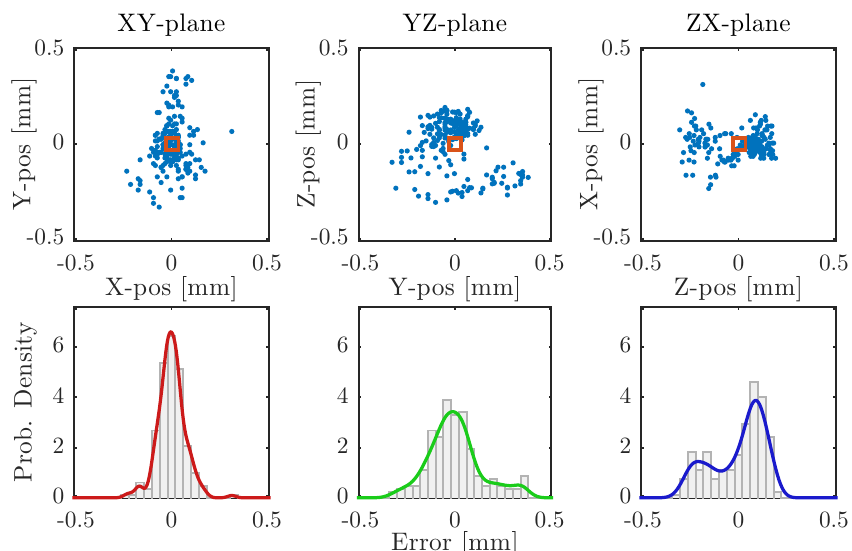
Figure 10. Planar position point-clouds ( top ) and deviation distribution ( bottom ) for 200 measurements of the pole-shoe TCP using an inductive proximity sensor (Sensor B).